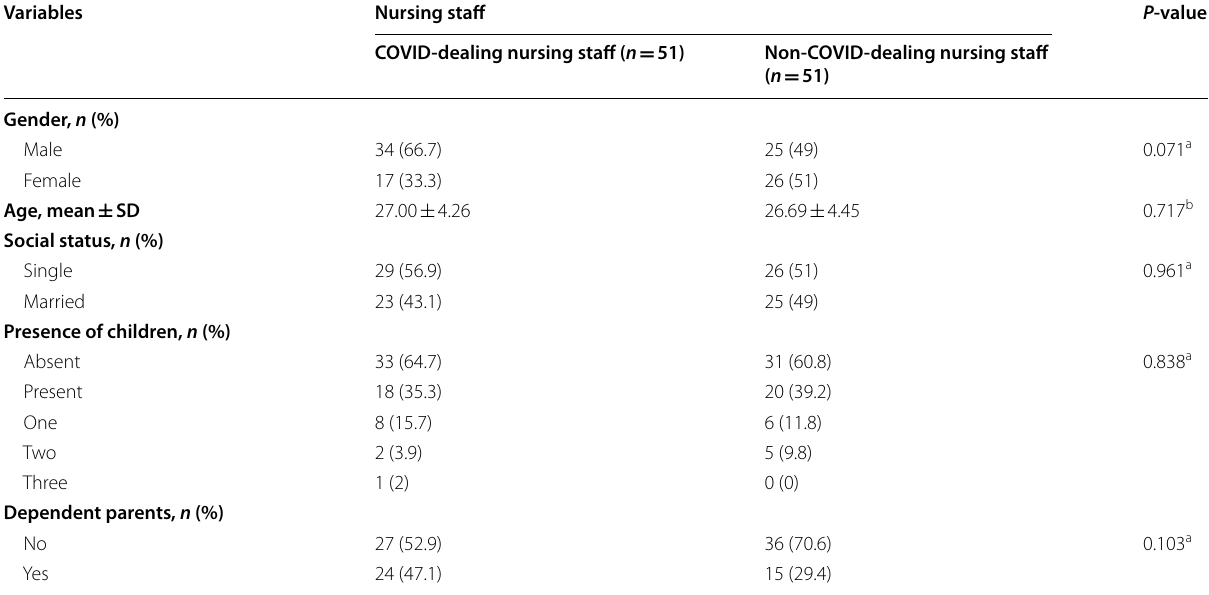
Table 1 Sociodemographic characteristics of the studied population